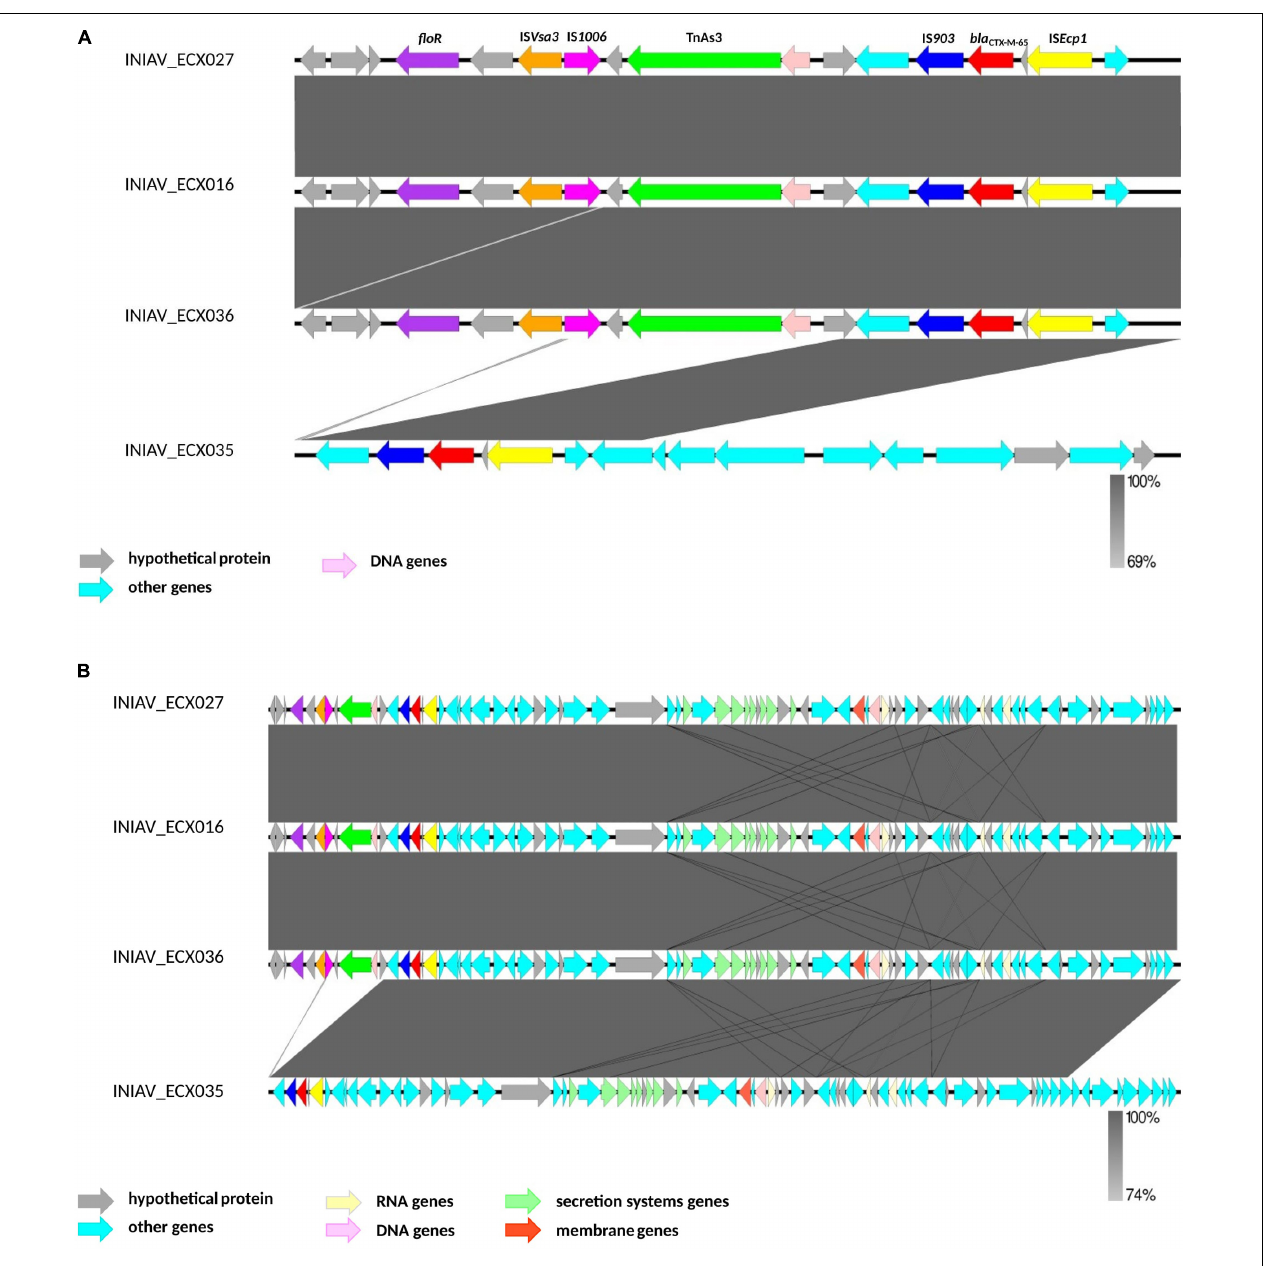
FIGURE 2 | Genetic platform of the bla CTX − M − 65 genes obtained by the analysis of the contigs containing the bla CTX gene using EasyFig. (A) A subregion of 17,000 bp of each contig to better identify the mobilization elements. (B) A subregion of 83,000 bp from the contigs.